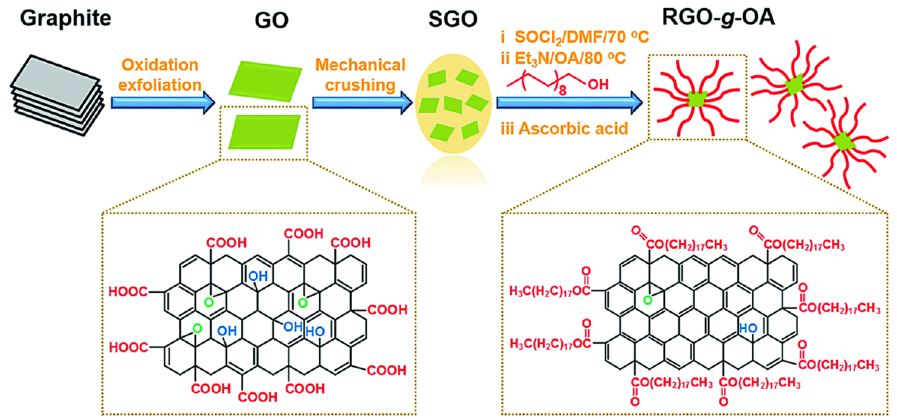
Figure 7. Schematic of preparation procedures for RGO-g-OA. Reproduced with permission from [61]. Copyright 2019 Royal Society of Chemistry.